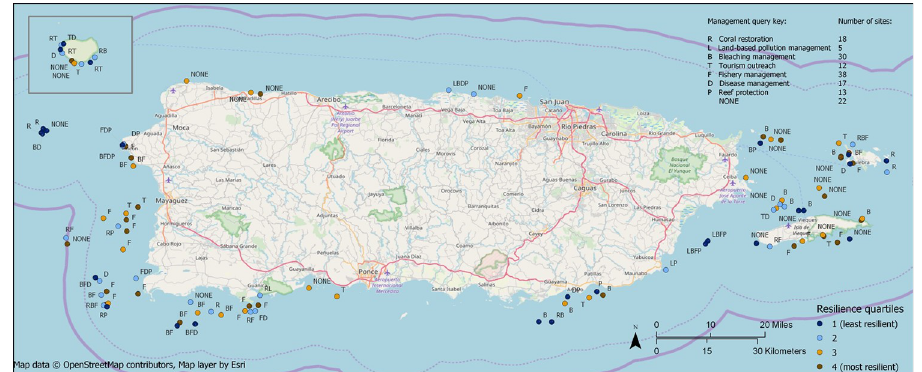
Fig 6. Reef survey sites (n = 103) showing which management queries applied to each site. Refer to Table 2 for criteria used in each query. Isla de Mona is the inset in the top left. Resilience quartiles are based on resilience calculated without the temperature variation